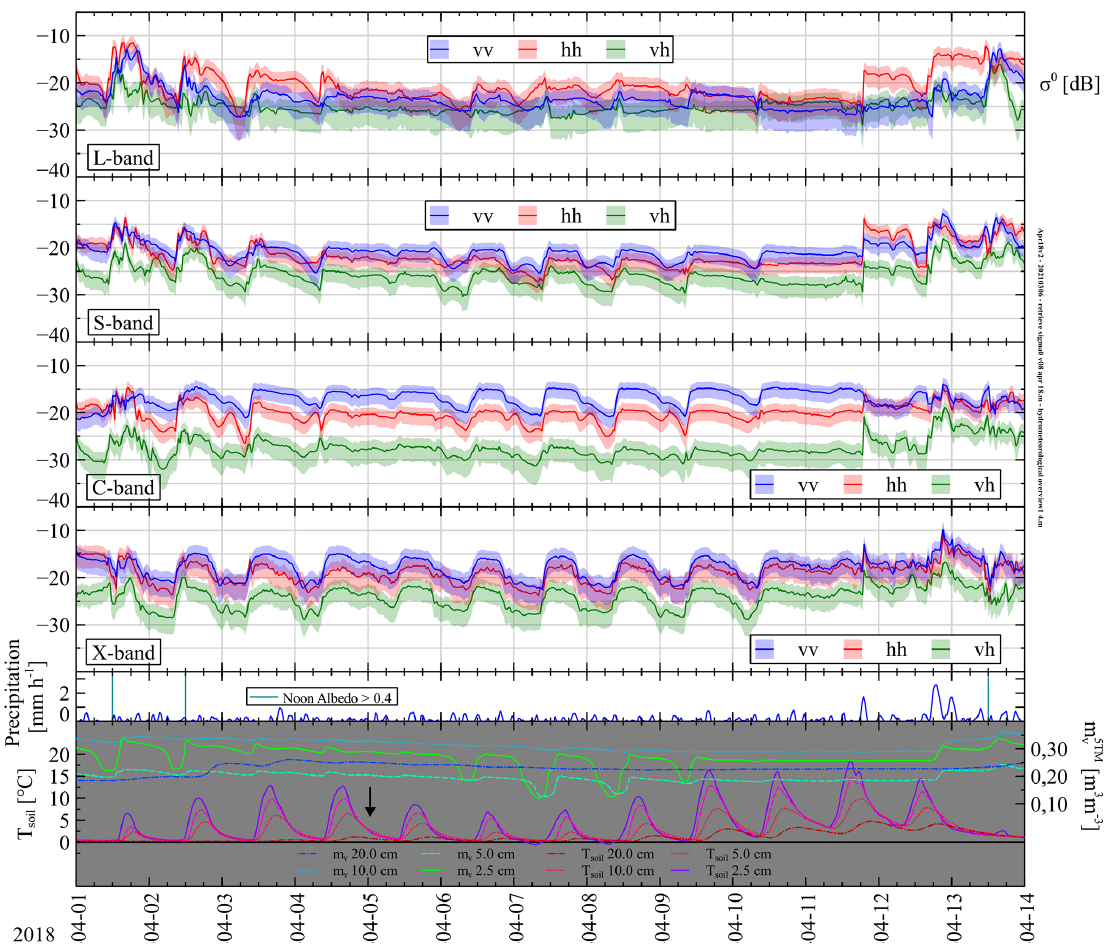
Figure 6. Time-series measurements of σ 0 pq (m 2 m − 2 ) for L-, S-, C-, and X-band, precipitation, M v , and T soil during 13d in April 2018. Shaded regions indicate 66% confidence intervals for σ 0 pq . The antenna boresight angle was fixed at α 0 = 55 ◦ . The incidence angle ranges were band and polarization dependent. The widest ranges were 0 ◦ ≤ θ ≤ 60 ◦ for L-band, 20 ◦ ≤ θ ≤ 60 ◦ for S-band, 36 ◦ ≤ θ ≤ 60 ◦ for C- band, and 47 ◦ ≤ θ ≤ 59 ◦ for X-band. Bottom graphs show measured precipitation (mmh − 1 ) (snowfall identified by noon albedo), volumetric soil moisture m 5TM v (m 3 m − 3 ), and soil temperature T soil at indicated depths. Arrow indicates thawing of soil at 25cm. Spatial average volumetric soil moisture content M v is estimated as M v = m 5TM v ± 0 . 04m 3 m − 3